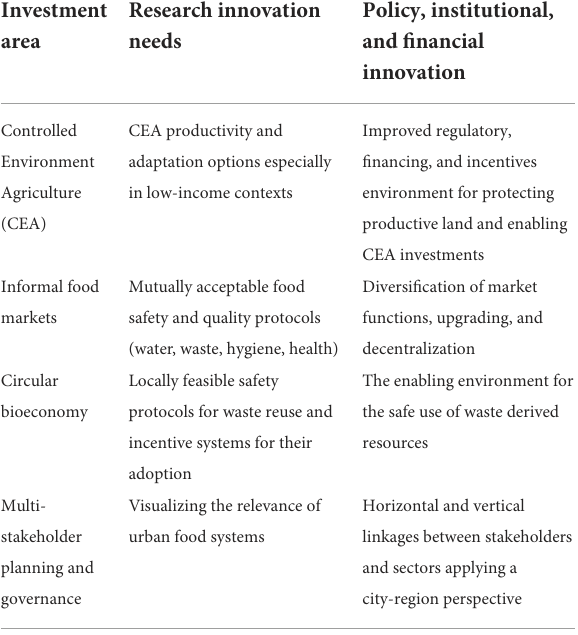
TABLE 1 Selected UPA research and innovation investment